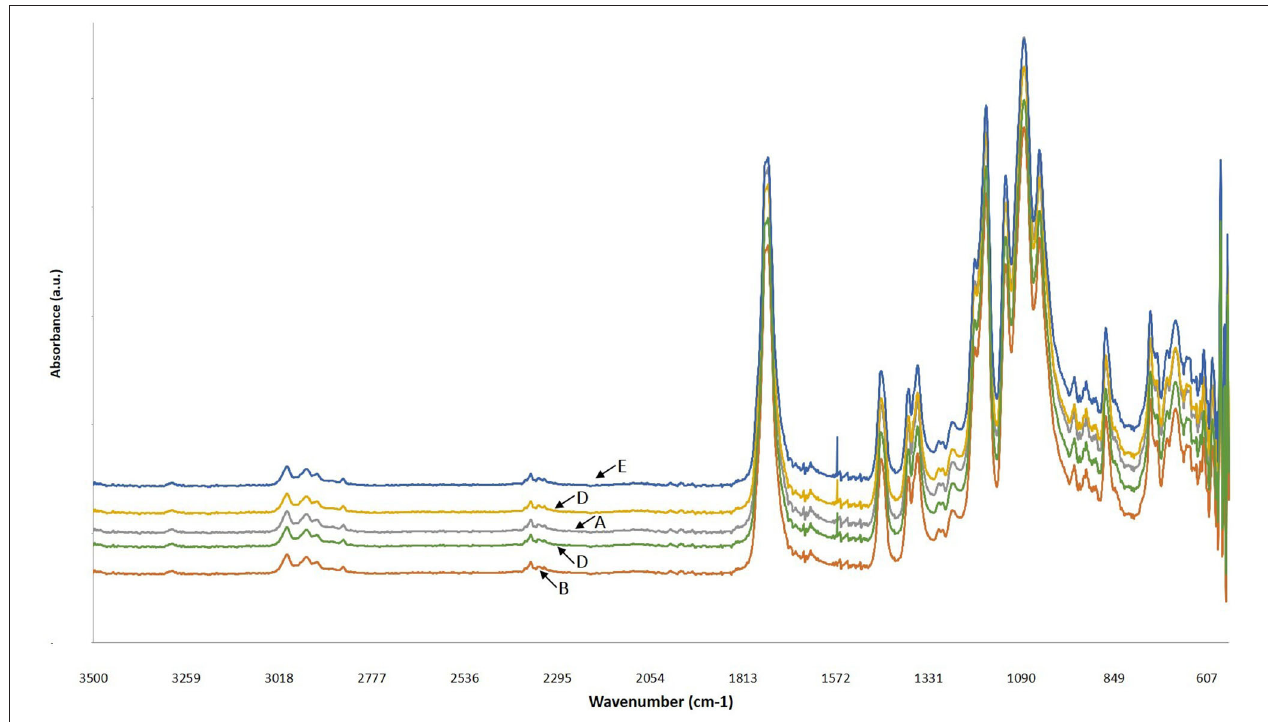
FIGURE 6 | FTIR spectra of (A) commercial PLA films (PLA-C), (B) PLA films manufactured from fermentation process (poly(L-lactic acid) (PLLA)), (C) PLLA-1% CNPs, (D) PLLA-3% CNPs, (E) PLLA-5% CNPs.